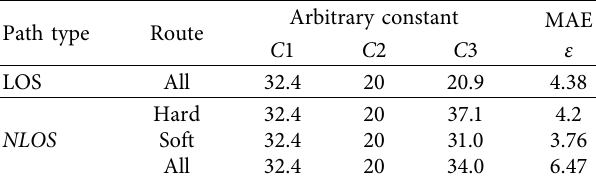
Table 3: Summary of the CI arbitrary constants of